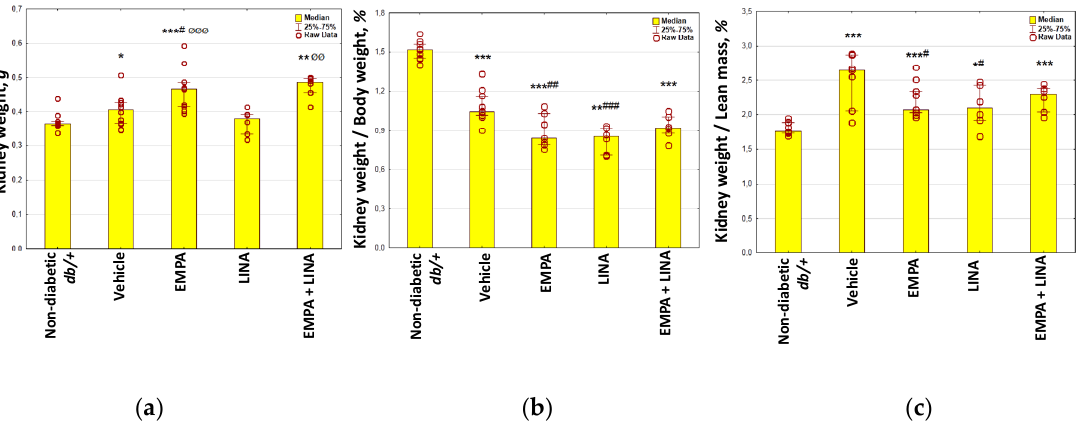
Figure 1. Parameters of kidney weight in non-diabetic db/+ mice and diabetic db/db mice: ( a ) kidney weight, g; ( b ) kidney weight/body weight ratio, %; ( c ) kidney weight/lean mass ratio, %. EMPA, empagliflozin-treated db/db mice; LINA, linagliptin-treated db/db mice; EMPA+LINA, empagliflozin– linagliptin-treated db/db mice. Data are presented as a bar graph (median, lower and upper quartile) with individual data set (dots); * p < 0.05, ** p < 0.01, *** p < 0.001 vs. non-diabetic control ( db/+ mice), # p < 0.05, ## p < 0.01, ### p < 0.001 vs. vehicle-treated db/db mice, ØØ p < 0.01, ØØØ p < 0.001 vs. linagliptin- treated db/db mice.